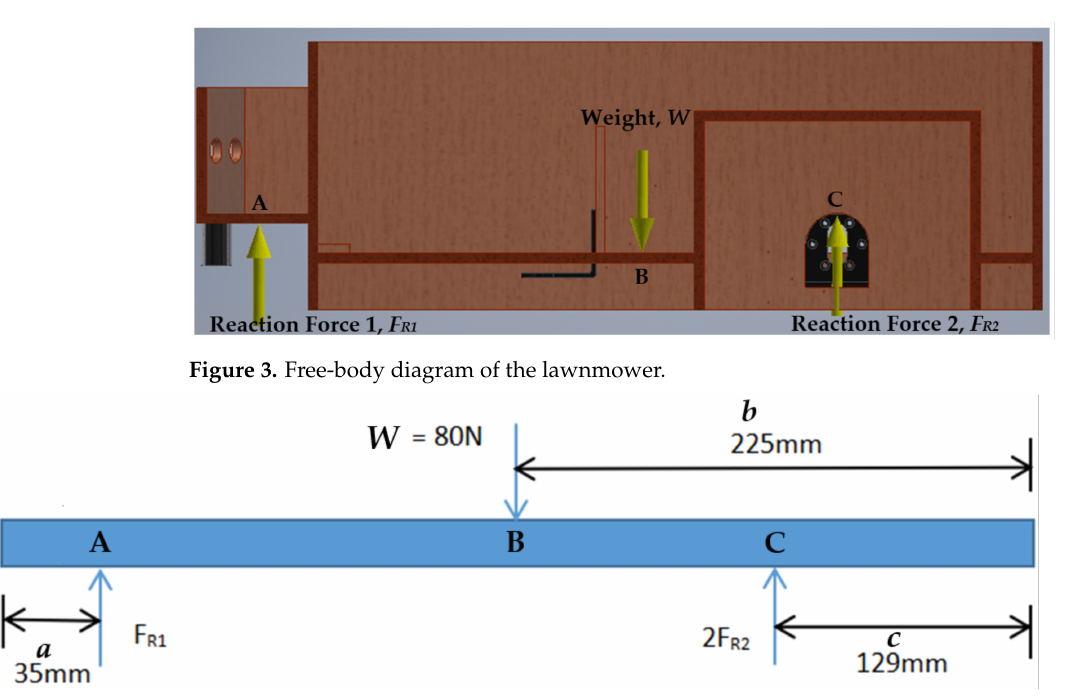
Figure 4. Simplified free-body diagram with known and unknown variables. Notes: a —distance from lawnmower front to point A; b —distance from point B to lawnmower rear; c —distance from point C to lawnmower rear; F R 1 —reaction force 1; F R 2 —reaction force 2; W —lawnmower